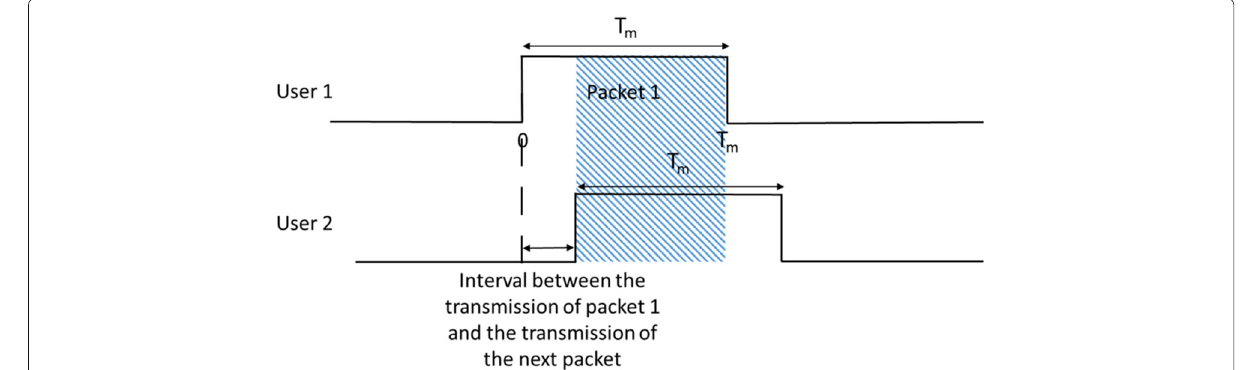
Fig. 6 Collision between packet 1 and a packet sent after it by another